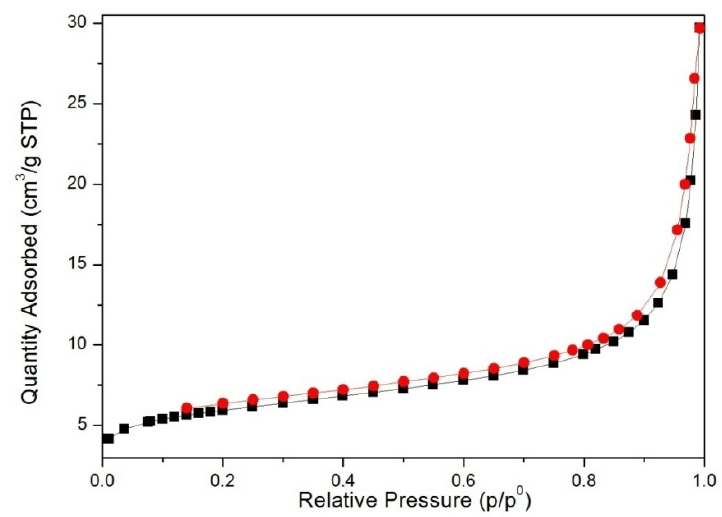
Figure 2. N 2 adsorption–desorption isotherms of Fe-MOFs.